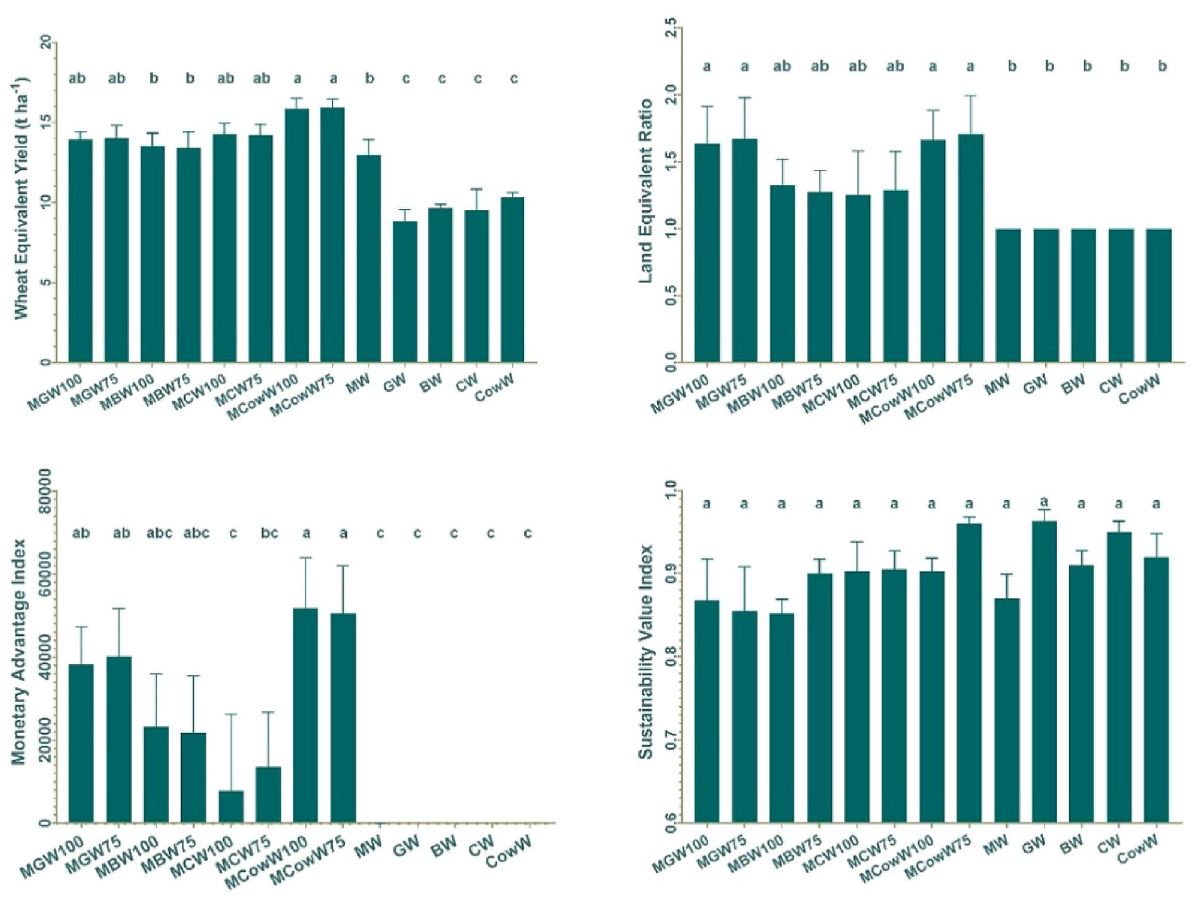
Figure 2. Effect of intercropping of legumes with Maize on competition